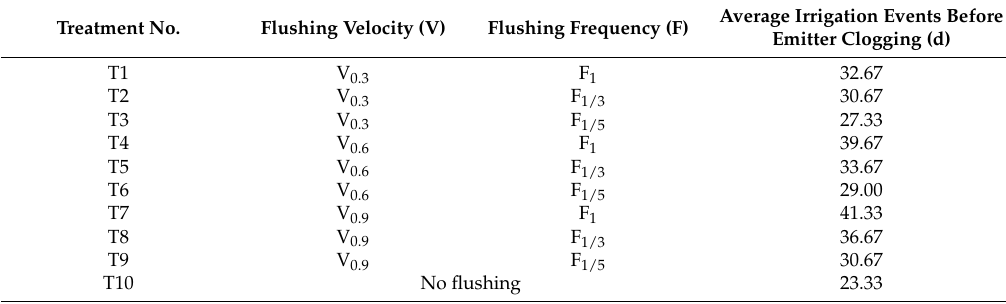
Table 2. Flushing velocity and flushing frequency